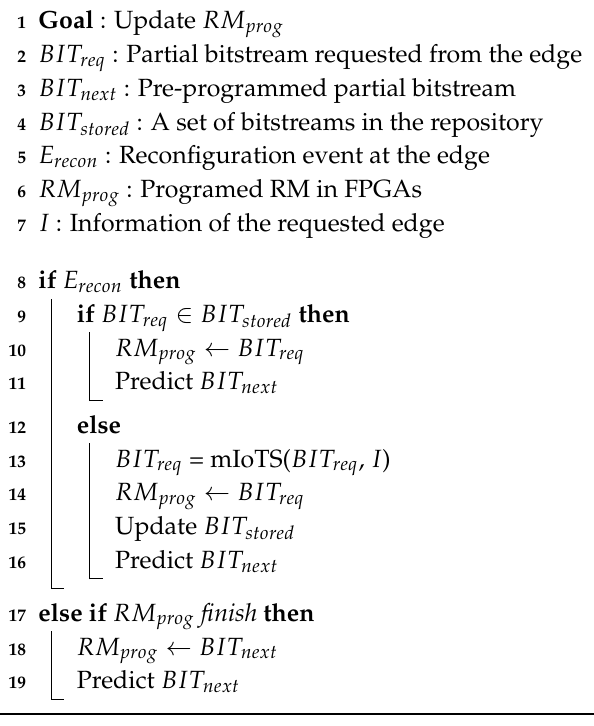
Algorithm 1: Edge bitstream caching algorithm.